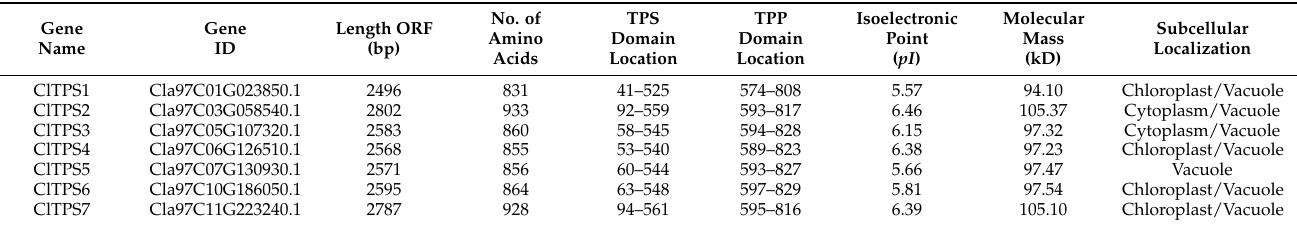
Table 1. Characteristics of TPS family members in